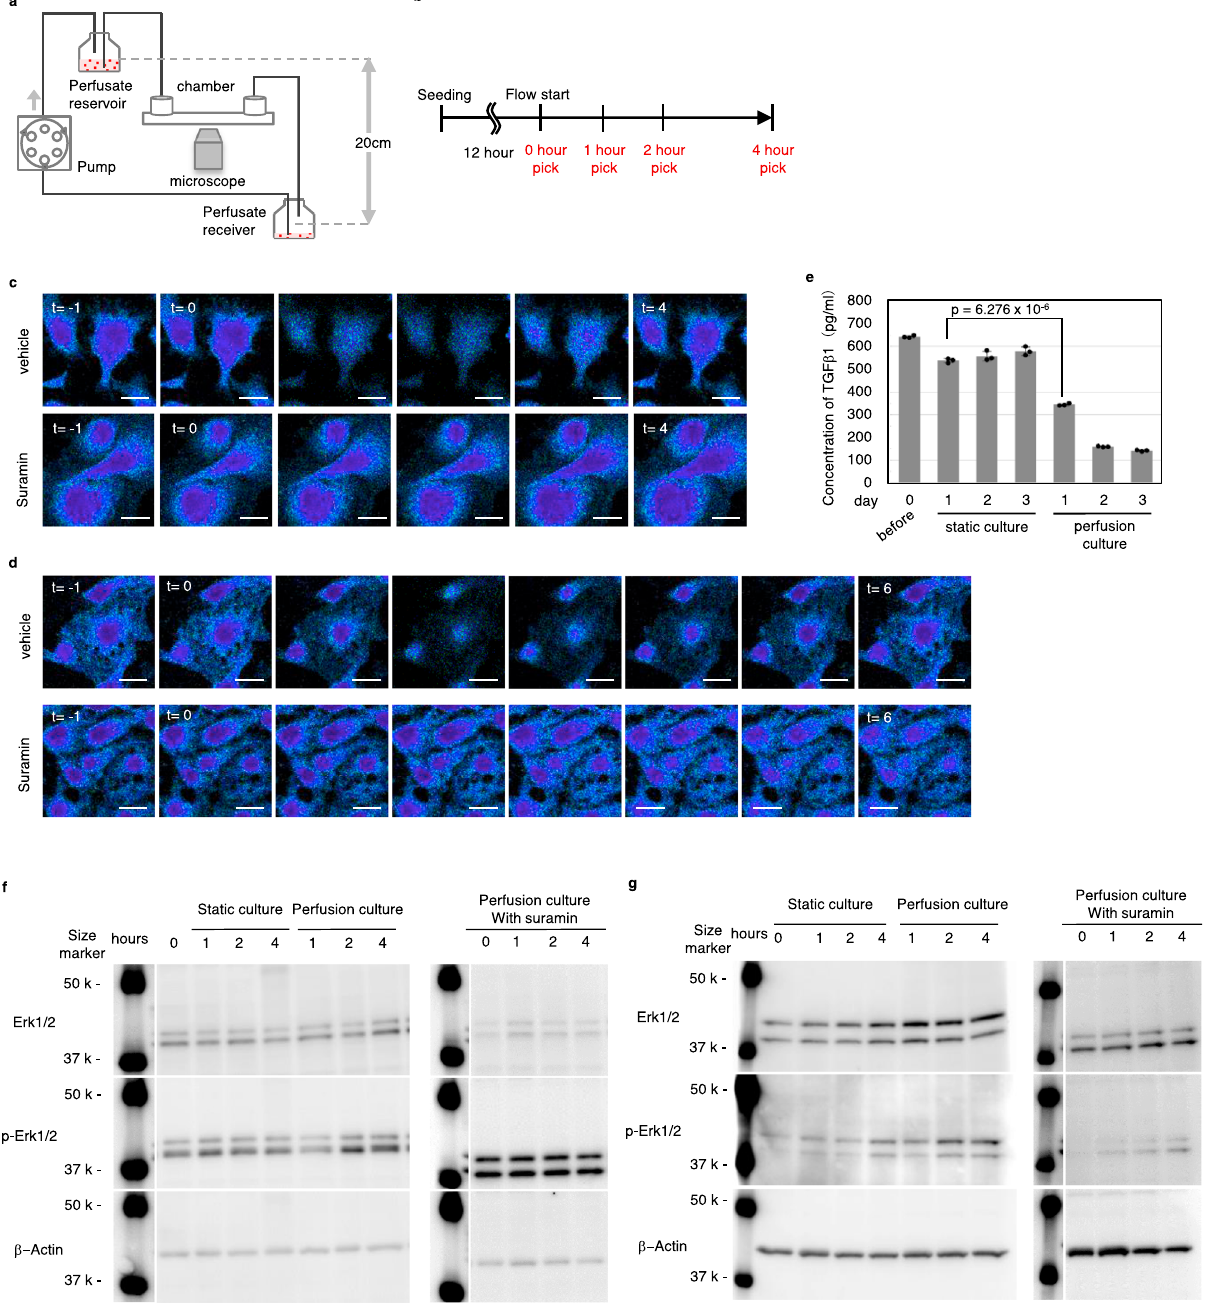
Fig. 4 Vascular endothelial cells sense shear stress via GPCRs. a Schematic of the shear stress loading circuit. The chamber was placed at 37 °C during culture and observation. b Time schedule of the shear stress test using liver sinusoidal endothelial cells. c Image of calcium in fl ux under shear stress loading using HUVECs. Each image was obtained at intervals of one second. Scale bar, 10 μ m. d Image of calcium in fl ux under shear stress loading using LSECs. Each image was obtained at intervals of 1 s. Scale bar, 10 μ m. e Concentration of TGF β 1 in supernatants using LSECs for 3 days under loading shear stress and static culture ( n = 1 and 3 for before and after culture, respectively). Data are presented as the mean ± SD. f Western blot analysis of Erk1/2 phosphorylation under shear stress with suramin using HUVECs. g Western blot analysis of Erk1/2 phosphorylation under shear stress with suramin using